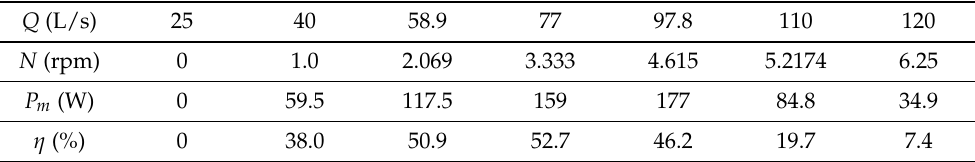
Table 2. Operating points of the HPM of straight blades of 1200 mm in diameter, from the simulations in caffa3d